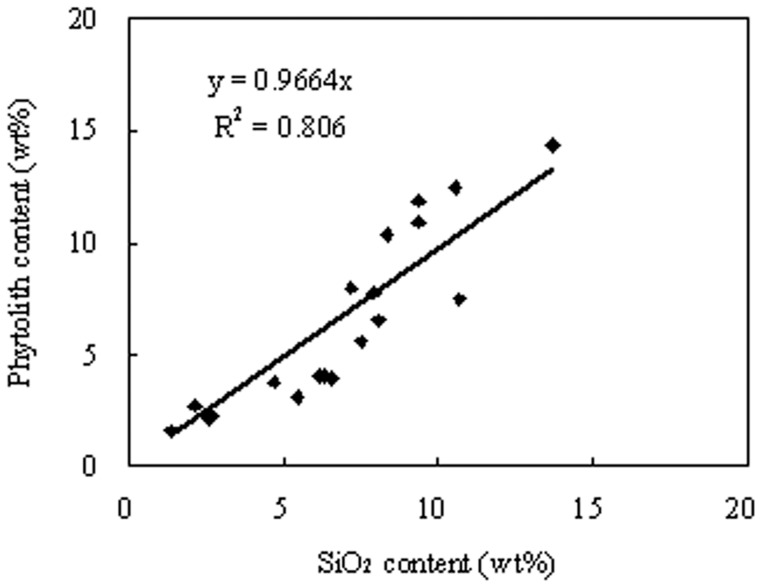
The correlation of phytolith content (%) to SiO2 (%) content in different crop species (p<0.01).